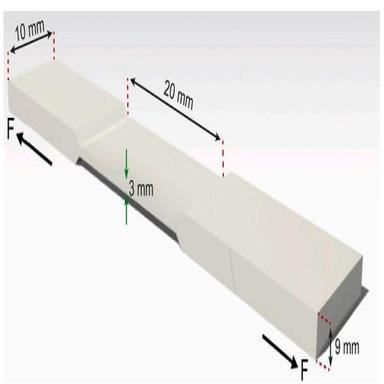
Dimensions of specimen for tensile test.